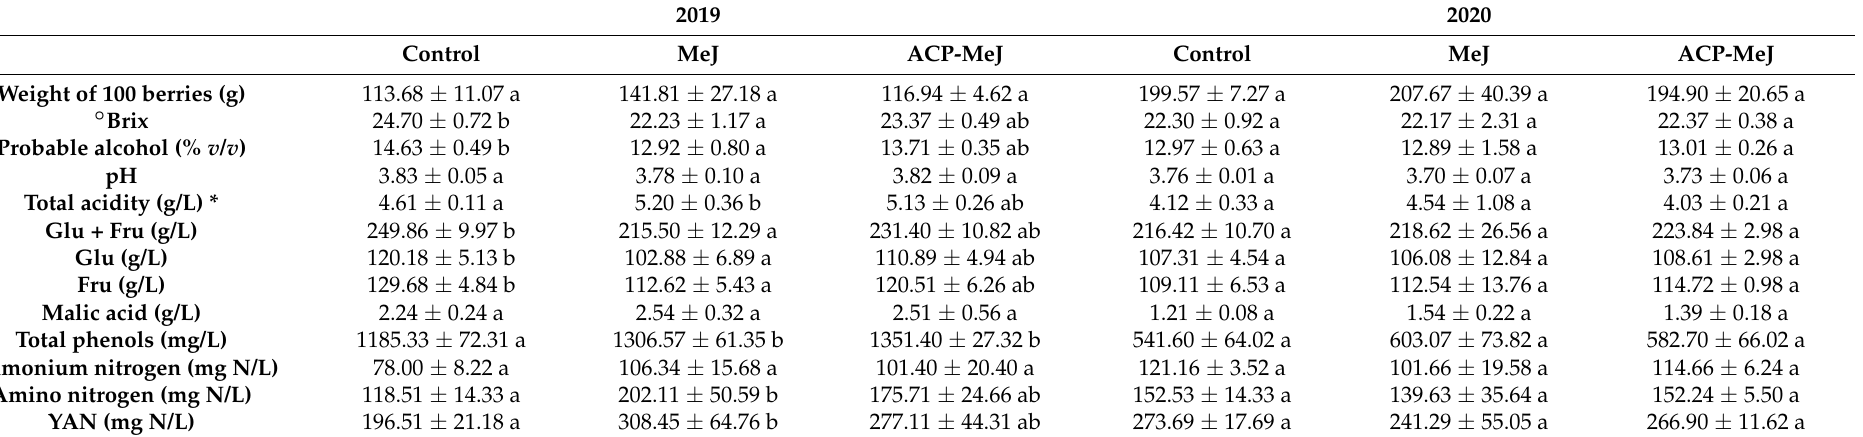
* As g/L of tartaric acid. YAN: yeast assimilable nitrogen. All parameters are listed with their standard deviation ( n = 3). For each season and parameter, different letters indicate significant differences between the samples ( p ≤